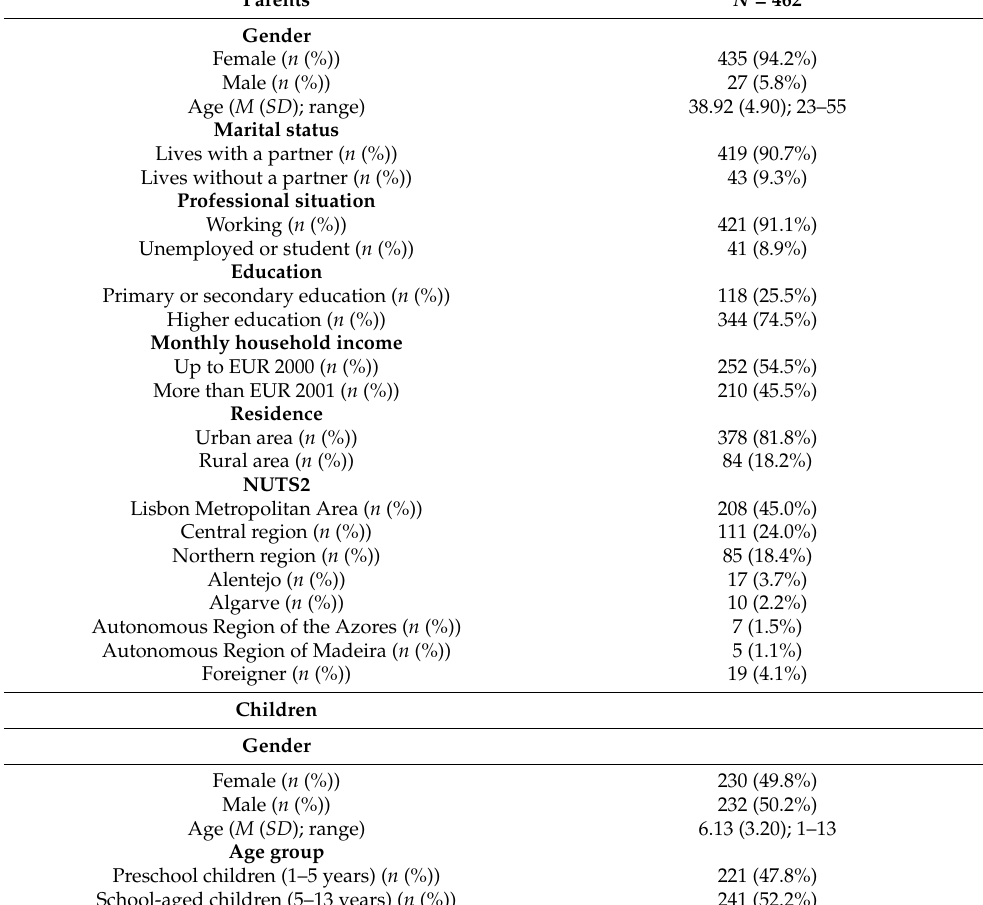
Table 1. Sociodemographic Characteristics of